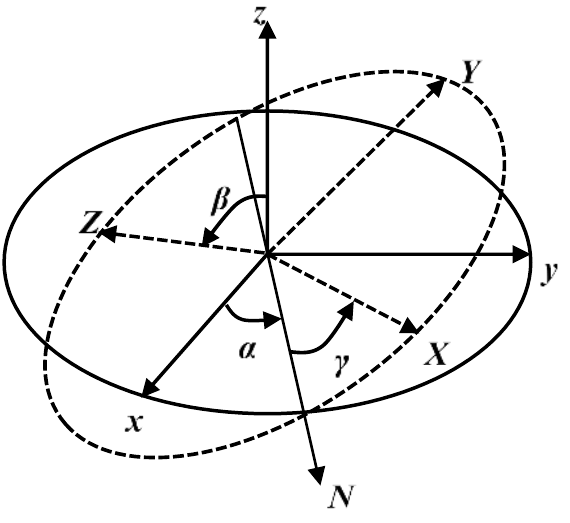
Figure 9. Coordinate transformation with Euler angles.